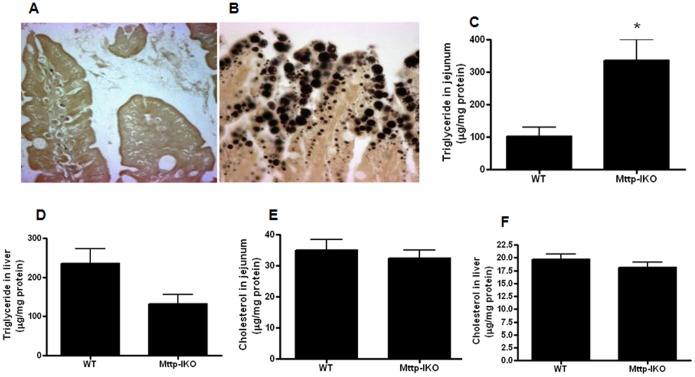
Effect of impaired intestinal lipid transport on intestinal and liver lipids.Villi of aged septic WT (A) and Mttp-IKO (B) mice stained with osmium tetroxide to detect intracellular lipid droplets. A massive upregulation is noted in these representative histomicrographs in Mttp-IKO mice, (magnification 40x). Triglyceride concentrations were increased in the jejunal mucosa (C, n = 5/group, p = 0.008) but not in the liver (D, n = 5/group, p = 0.056). Cholesterol levels were similar in both jejunal mucosa (E, n = 5/group, p>0.05) and liver (F, n = 5/group, p>0.05).